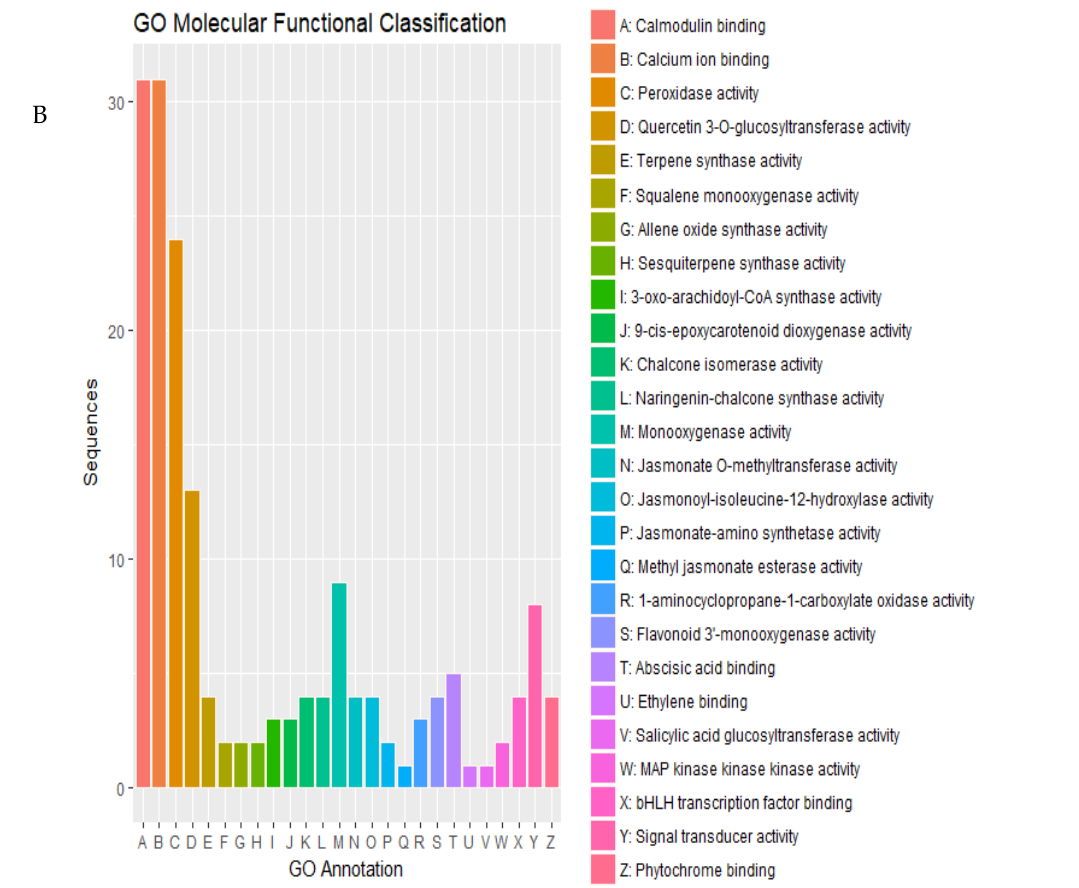
Figure 4. Gene ontology enrichment showing ( A ) the biological processes and ( B ) molecular functions associated with the differentially expressed genes in both cultivated and tolerant wild pigeonpea genotypes.